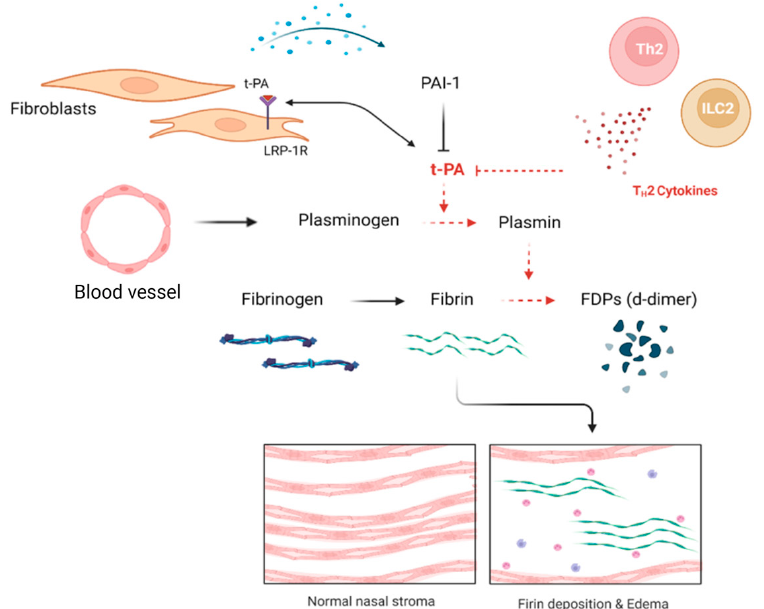
Figure 3. The role of nasal fibroblasts in the fibrinolytic system. The enzyme tPA binds to LRP-1R of fibroblast and induces the production of ECM such as collagen. However, fibroblasts activated by Th2 cytokine or other stimulators increase PAI-1 expression, and tPA suppressed by Th2 cytokine reduces ECM expression. In addition, a decrease in tPA causes an impairment of the fibrinolysis system and induces fibrin deposition.